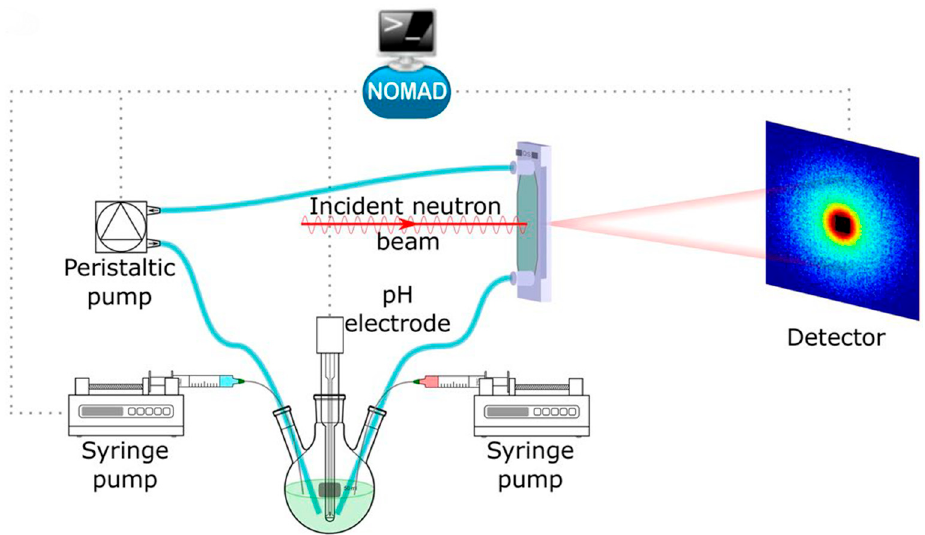
Figure 9. Schematic of an experimental set-up that allows structure formation due to chemical reactions to be followed in real time by SANS. The system consists of a reaction vessel where the reactions can be initiated using remotely controlled syringe pumps. A peristaltic pump is used to bring the mixture to the measuring cell. The system has the option to be used in open or closed loop configuration. In a closed loop system, one can, for instance, observe the effects of a gradual change in pH. Here, ‘Nomad’ is the name of the central control computer (reproduced with permission from [78], Springer Nature, 2018).